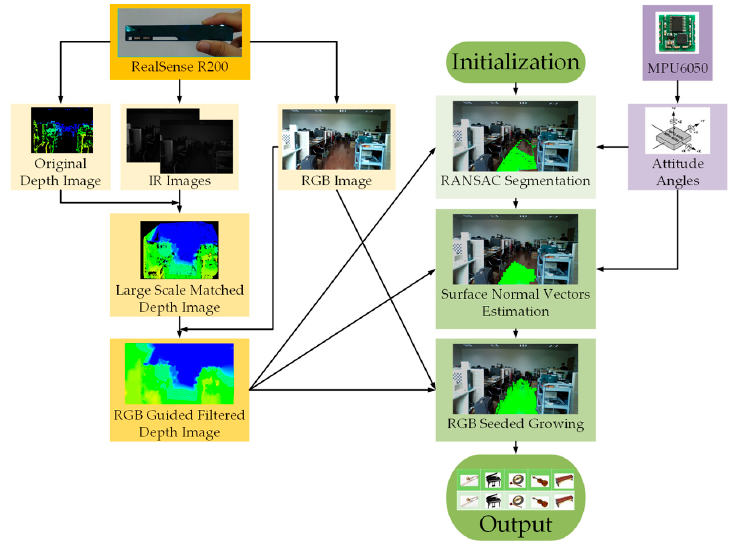
Figure 4. The flowchart of the approach.